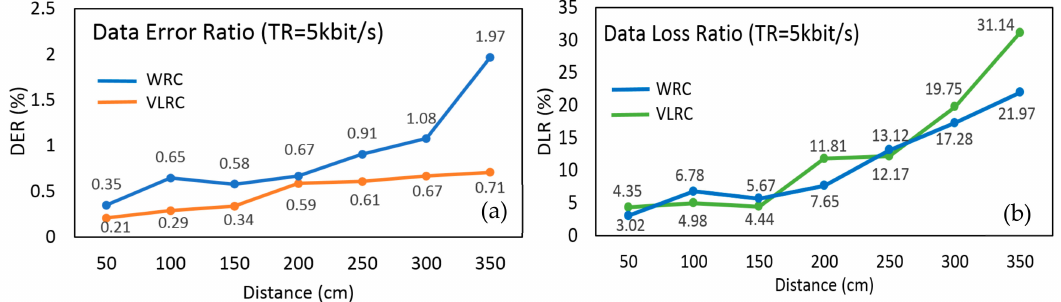
Figure 10. Experimental setting for communication quality testing.